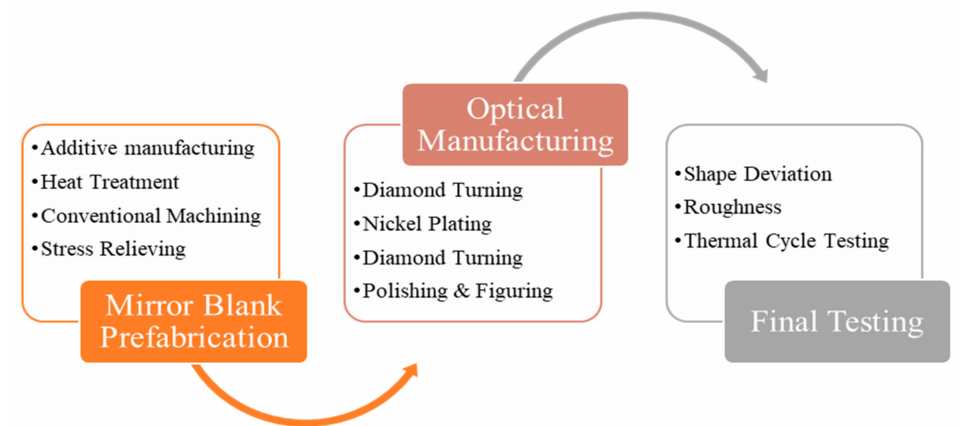
Figure 7. Processing chain for an AM metal